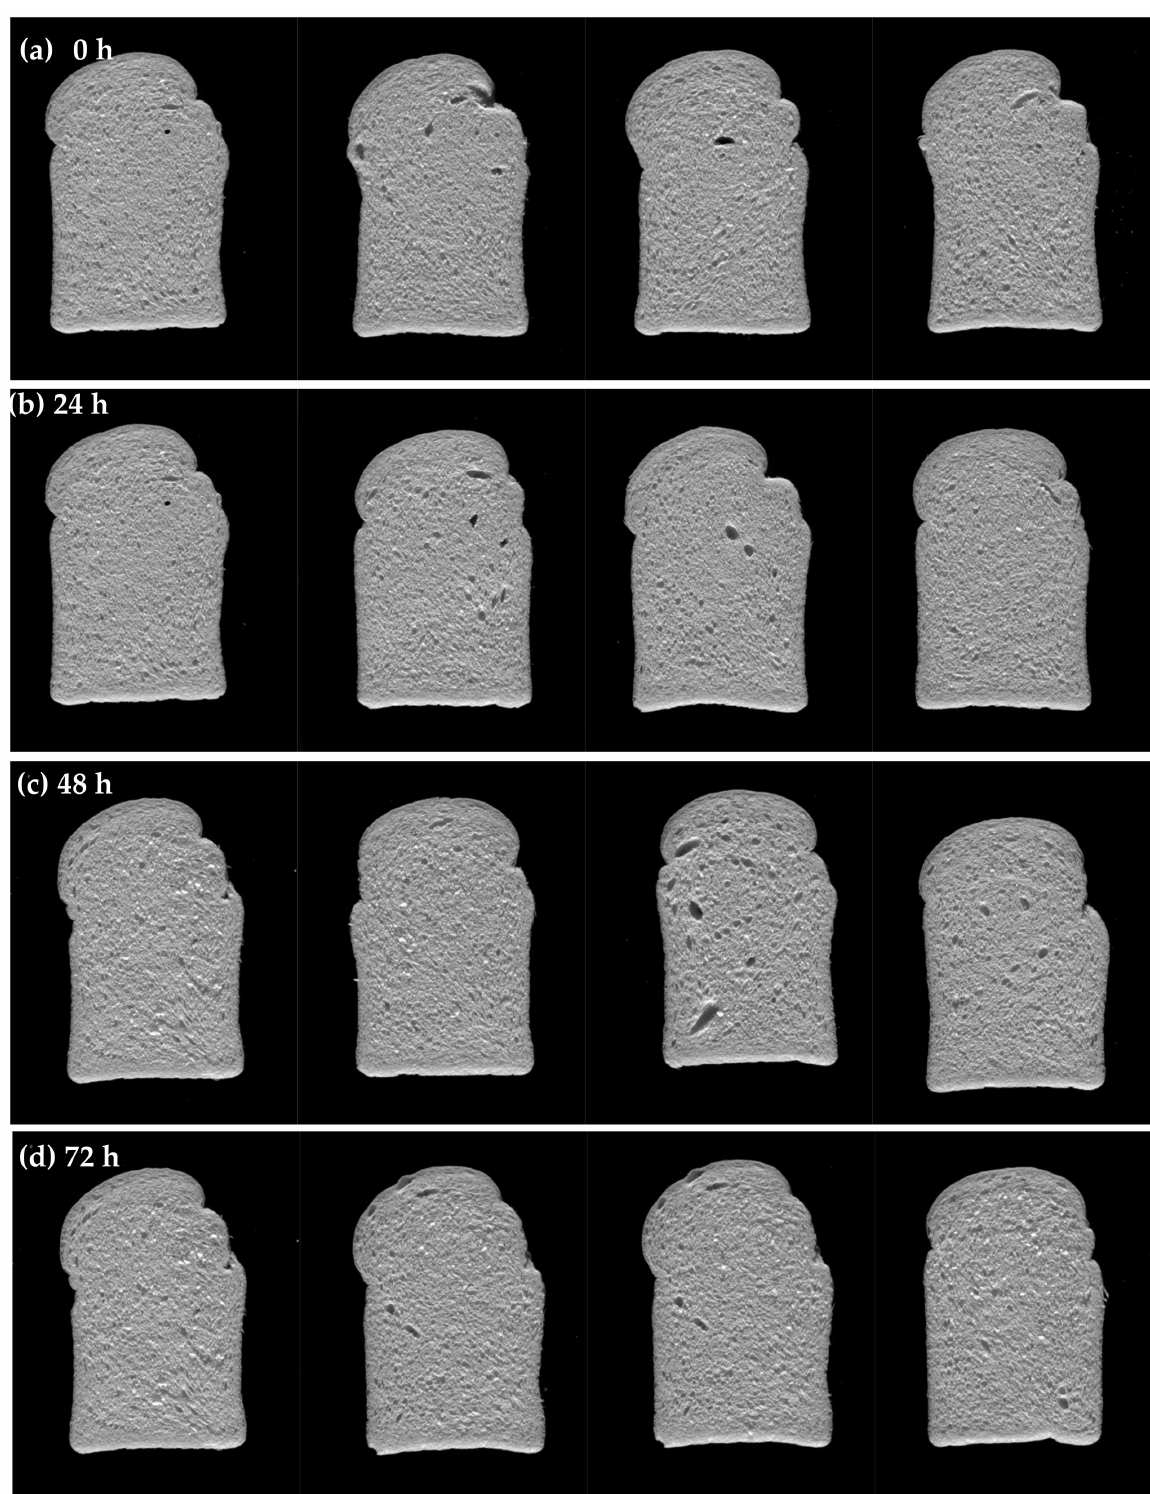
Figure 5. Slices of bread made with fresh ferment and stored over a 72 h period. ( a ) 0 h of storage, ( b ) 24 h of storage, ( c ) 48 h of storage, and ( d ) 72 h of storage. Left to right: control (no ferment), 30% ferment inclusion, 50% ferment inclusion, and 70% ferment